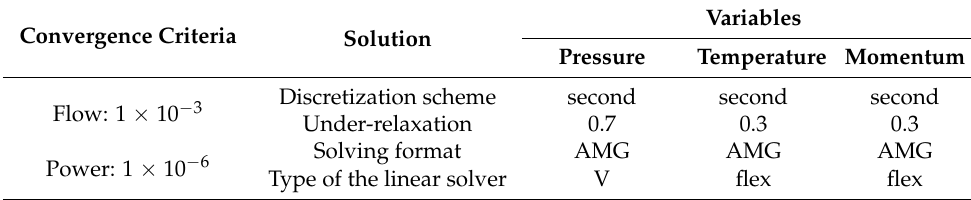
Table 5. The parameters of the discretization solution.